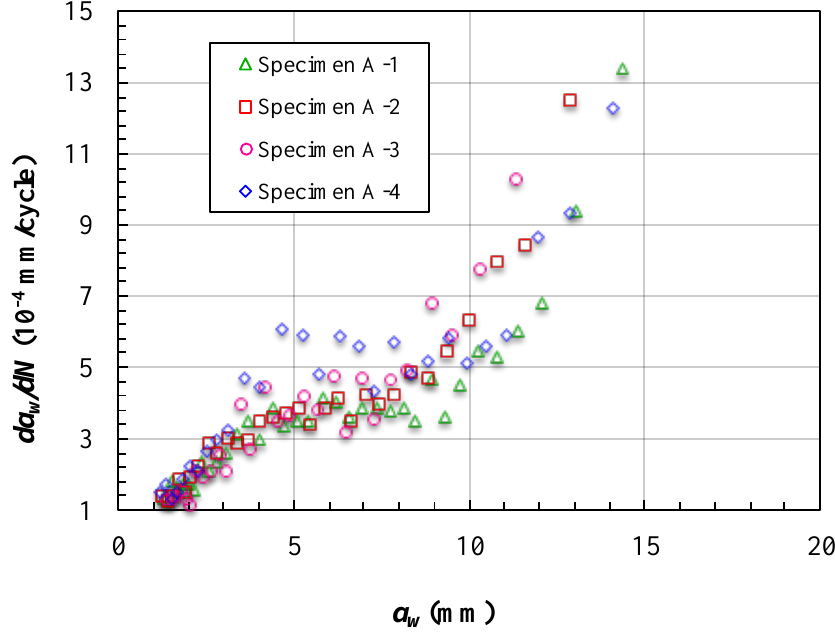
Figure 11. FCG rate at different crack lengths a w of specimens of Group A.